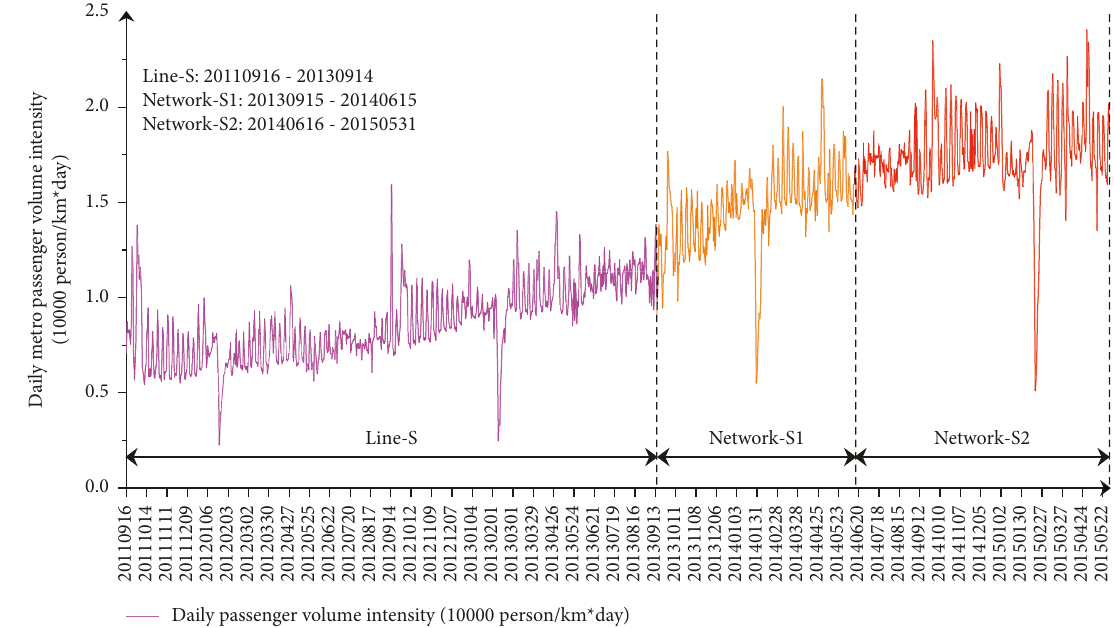
Figure 3: The temporal distribution of daily passenger volume